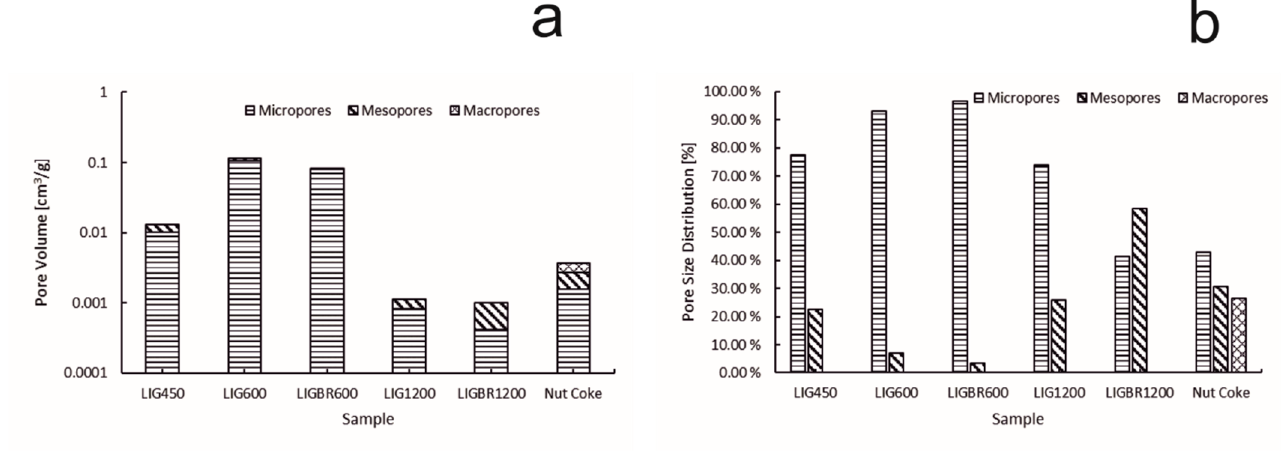
Figure 9. Pore volumes and pore size distributions of the samples. ( a ): pore volume of the samples; ( b ):pore size distribution of the samples.